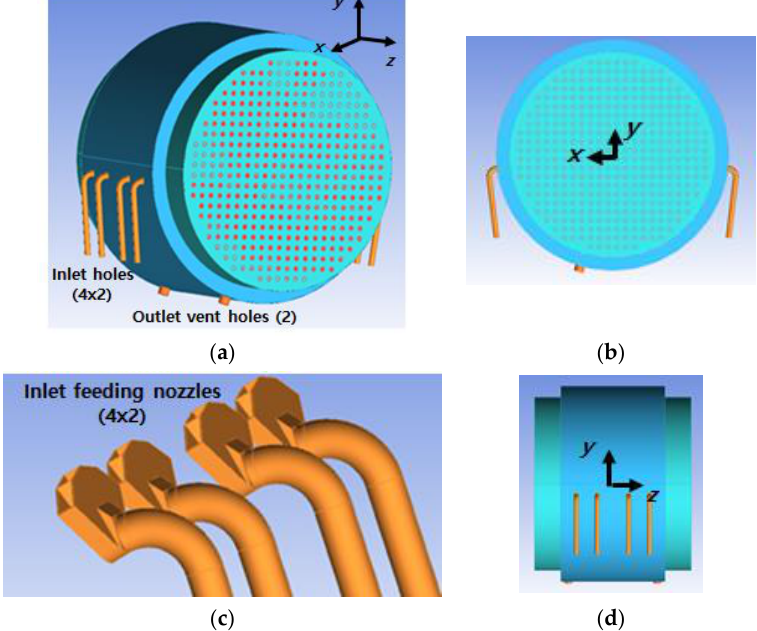
Figure 2. 3-D modeling of the Prototype: ( a ) 3-D shape; ( b ) axial view; ( c ) feeding nozzles; ( d ) side view.